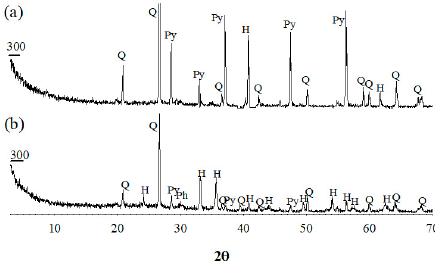
Figure 2. X-ray diffraction (XRD) patterns for the gold concentrates ( a ) before and ( b ) after microwave irradiation for 10 min (H: hematite; Py: pyrite; Ph: pyrrhotite; Q: quartz).